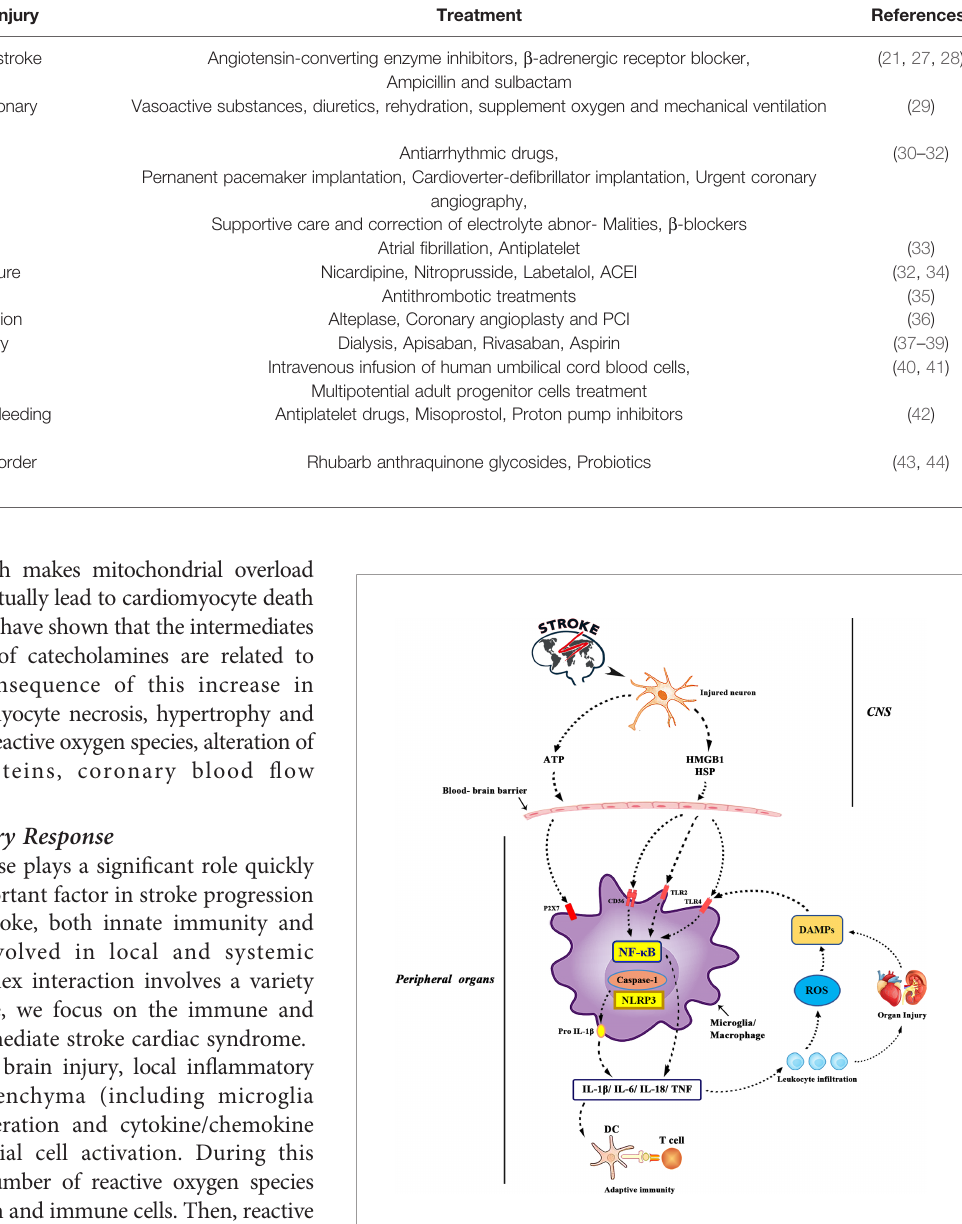
FIGURE 2 | ATP is released from damaged neurons, activating purinergic receptors on microglia and macrophages and leading to the production of pro-in fl ammatory cytokines. Interleukin-1 converting enzyme (ICE; caspase1) is embedded in a polyprotein complex (NLRP3 or in fl ammatory body) and activated by P2X7 receptors in microglia. Cell death leads to the formation of DAMPs, which activates TLR, especially TLR2 and TLR4. DAMPs released by ischemia includes high mobility group protein B1, heat shock protein 60 and so on. TLRs binds to scavenger receptors (such as CD36) and up-regulates the expression of in fl ammatory genes through transcription actor nuclear factor-kB. DAMPs is also produced by matrix decomposition caused by lyases released by dead cells and the effect of reactive oxygen species on lipids. Finally, the production of cytokines and the activation of complement lead to the increase of leukocyte in fi ltration and tissue damage, which leads to the production of more DAMPs. The antigen revealed by tissue injury was presented to T cells, which laid the foundation for adaptive